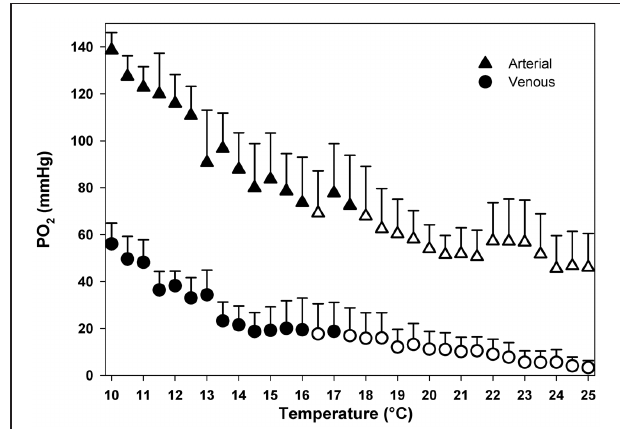
FIGURE 5 | Temperature dependent patterns of arterial and venous oxygen partial pressure, during acute warming from 10 to 25 ◦ C. Open symbols denote values that are significantly different from the respective controls, Dunnett’s test ( P < 0 . 05). Data are means ± s.e.m., n = 4.